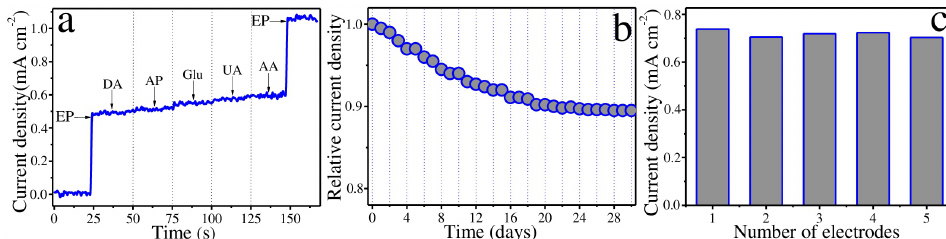
Figure 6. ( a ) Interference test of Au–Ru electrode in 0.1 M PBS (pH 7.0) at a working potential of 0.28 V with 100 µ M epinephrine (EP) and other interfering analytes, including 50 µ M dopamine (DA), 50 µ M acetaminophen (AP), 50 µ M D-glucose (Glu), 50 µ M uric acid (UA) and 50 µ M ascorbic acid (AA). ( b ) Long-term stability of Au–Ru electrode towards non-enzymatic epinephrine sensing investigated during one month. ( c ) The results of the reproducibility test obtained for five